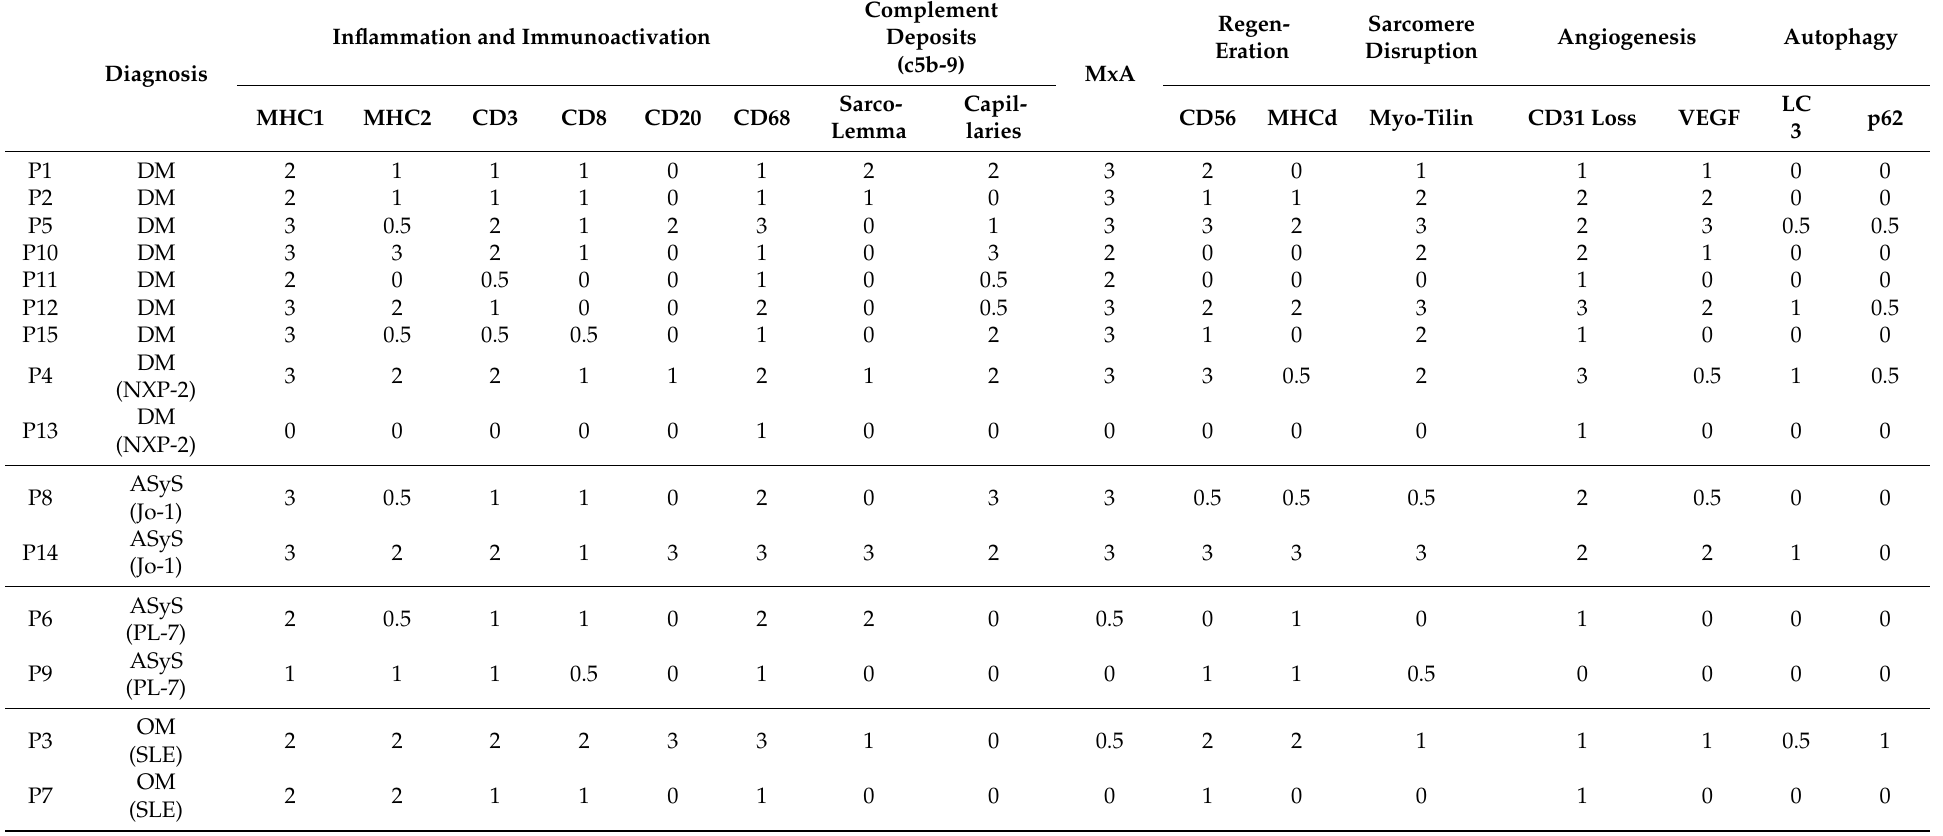
Table A2. Scoring of muscle pathology at IH